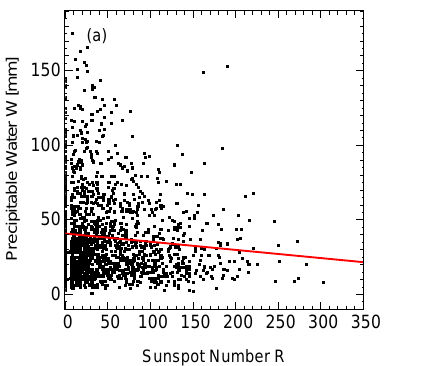
Fig. 5. (a) The brightness A of the solar aureole (pyranometry) versus sunspot number for Cerro Montezuma and airmass 1.5, showing a very similar trend to the one presented in Figure 1 of W10. The linear slope has a value of − 0 . 0093 ± 0 . 0010 . (b) Same as before, but for the corrected values of the pyranometry, i.e. with the deviation of the monthly medians from the annual average subtracted to correct for seasonalvariations,andwithoutthedatafromyearsaffectedbyvolcanicaerosolsorlocalpollution. Theredlineindicatesalinearregression to the data, showing no statistically significant trend with sunspot number (slope − 0 . 0022 ± 0 . 0008 ). The blue circles and their error bars illustratemedianvaluesandthevarianceinfoursunspot-numberintervals.